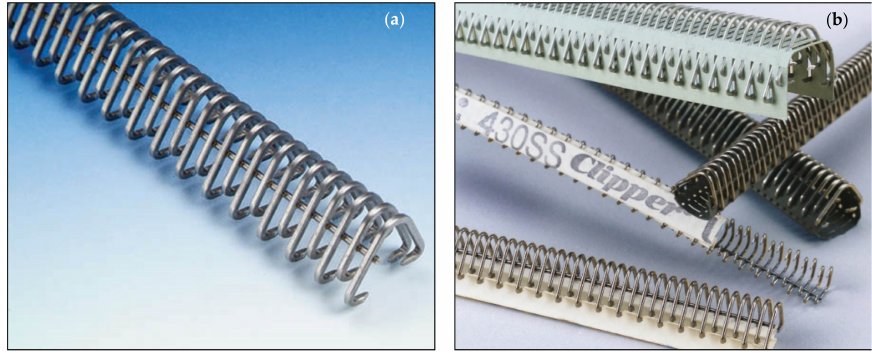
Figure 15. Wire hook fastening: ( a ) welded to a common rod; ( b ) carded